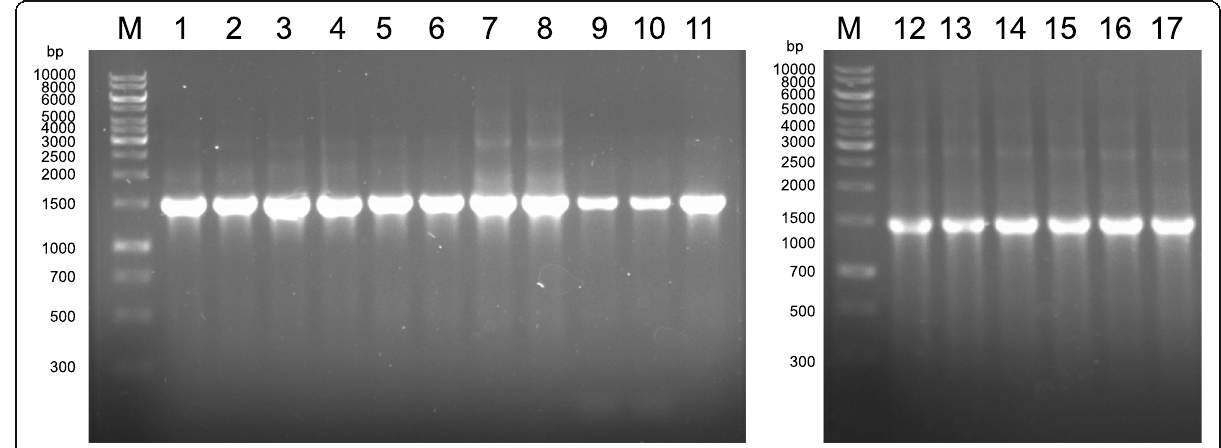
Fig. 1 Amplified 16S rRNA of isolates on 1% (w/v) agarose gel. From left: lane M (1 kb DNA ladder), 1 (C1 Blue 1), 2 (C1 Blue 2), 3 (C1 Blue 3), 4 (C1), 5 (C1 Acid), 6 (C3SD), 7 (C3OSS), 8 (A1 LY), 9 (A3 SWS), 10 (S1), 11 (S2), 12 (B1SS), 12 (S3), 13 (S4), 14 (S5), 16 (S6), and 17